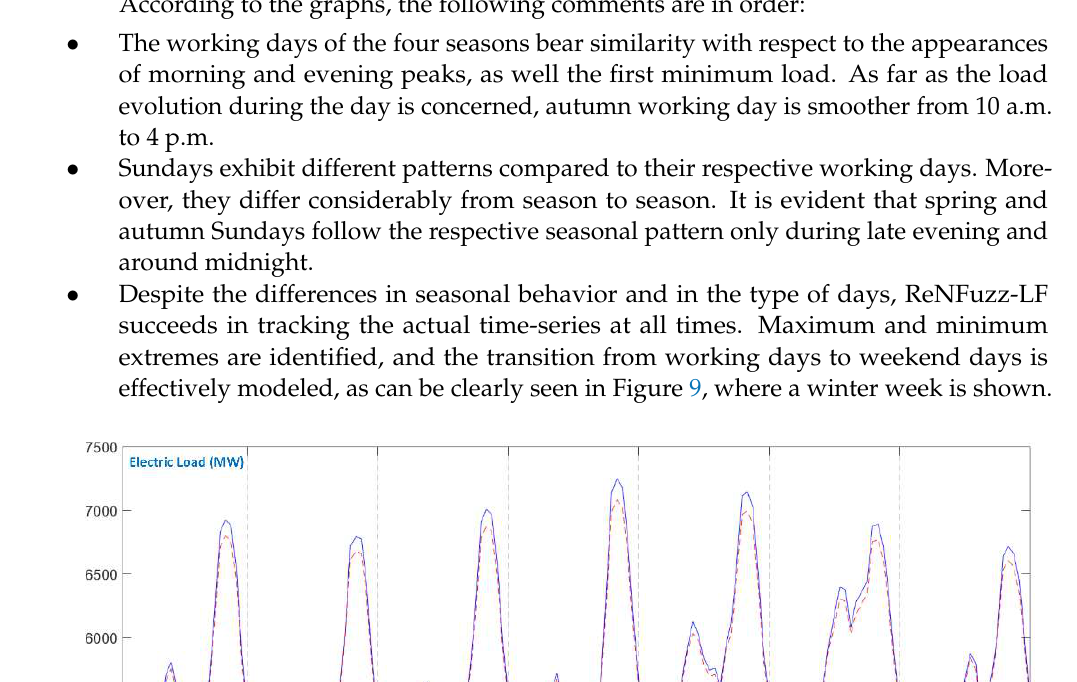
Figure 8. Presentation of autumn days. The blue solid line is the actual electric load, and the red dotted line is ReNFuzz-LF’s output: ( a ) working day; ( b ) Sunday. According to the graphs, the following comments are in order: